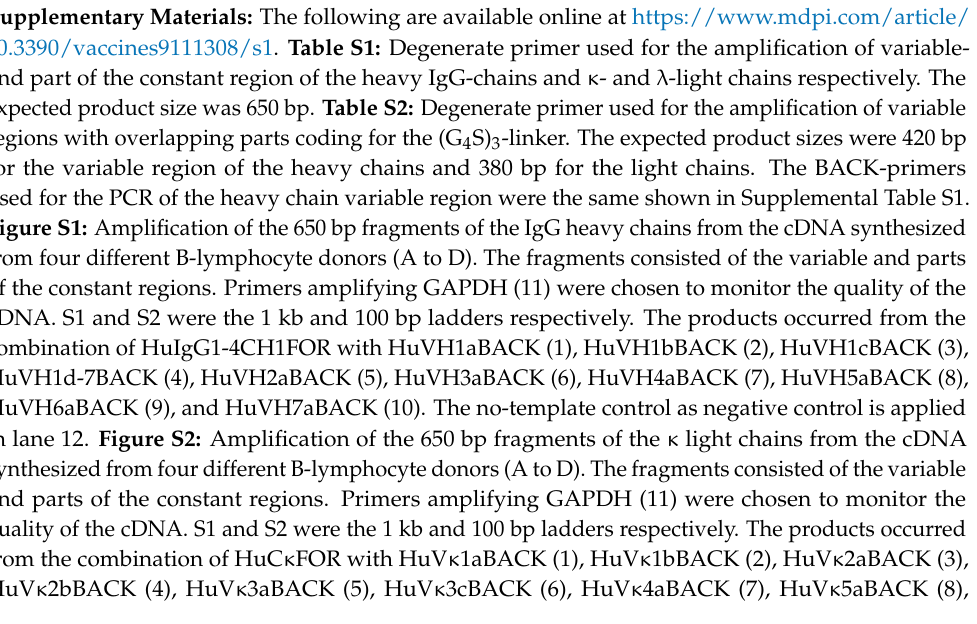
Figure S1: Amplification of the 650 bp fragments of the IgG heavy chains from the cDNA synthesized from four different B-lymphocyte donors (A to D). The fragments consisted of the variable and parts of the constant regions. Primers amplifying GAPDH (11) were chosen to monitor the quality of the cDNA. S1 and S2 were the 1 kb and 100 bp ladders respectively. The products occurred from the combination of HuIgG1-4CH1FOR with HuVH1aBACK (1), HuVH1bBACK (2), HuVH1cBACK (3), HuVH1d-7BACK (4), HuVH2aBACK (5), HuVH3aBACK (6), HuVH4aBACK (7), HuVH5aBACK (8), HuVH6aBACK (9), and HuVH7aBACK (10). The no-template control as negative control is applied in lane 12. Figure S2: Amplification of the 650 bp fragments of the κ light chains from the cDNA synthesized from four different B-lymphocyte donors (A to D). The fragments consisted of the variable and parts of the constant regions. Primers amplifying GAPDH (11) were chosen to monitor the quality of the cDNA. S1 and S2 were the 1 kb and 100 bp ladders respectively. The products occurred from the combination of HuC κ FOR with HuV κ 1aBACK (1), HuV κ 1bBACK (2), HuV κ 2aBACK (3), HuV κ 2bBACK (4), HuV κ 3aBACK (5), HuV κ 3cBACK (6), HuV κ 4aBACK (7), HuV κ 5aBACK